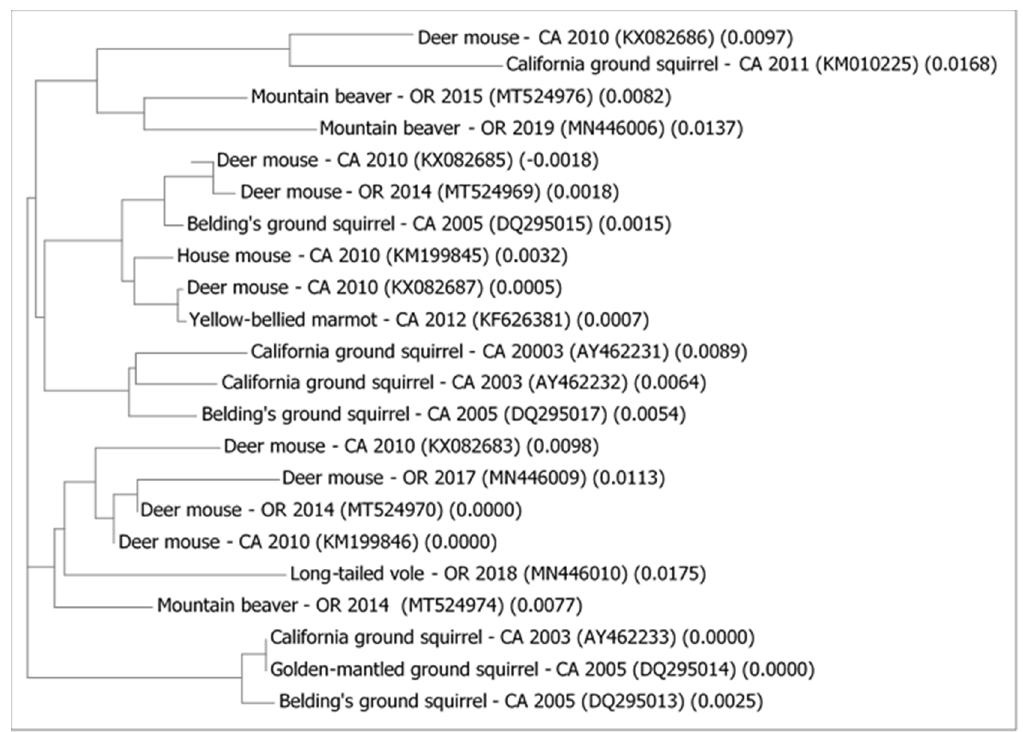
Figure 1. Phylogenetic relationships among relatively recent Cryptosporidium isolates from wild rodent species from the west coast of the US (California (CA), Oregon (OR)). GenBank accession numbers in the brackets after the name of the host species of rodent, its geographical location, and year when the isolate was obtained. Table 1. Comparison of relatively recent isolates of Cryptosporidium sp. from wild rodents to 18S rRNA genes of Cryptosporid- ium spp., genotypes, and isolates in